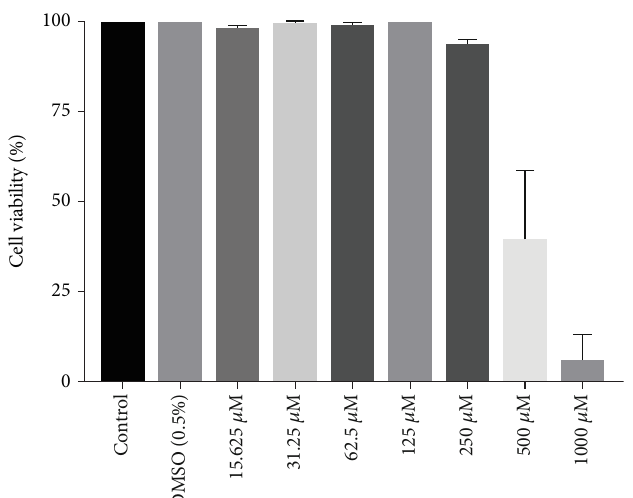
Figure 4: Viability of ARPE-19 cells treated with di ff erent concentrations of diacerein. Cell viability was determined by the MTS assay. Results show that diacerein had no signi fi cant cytotoxic e ff ect on ARPE-19 cells. The data are expressed as mean ± SD of three independent